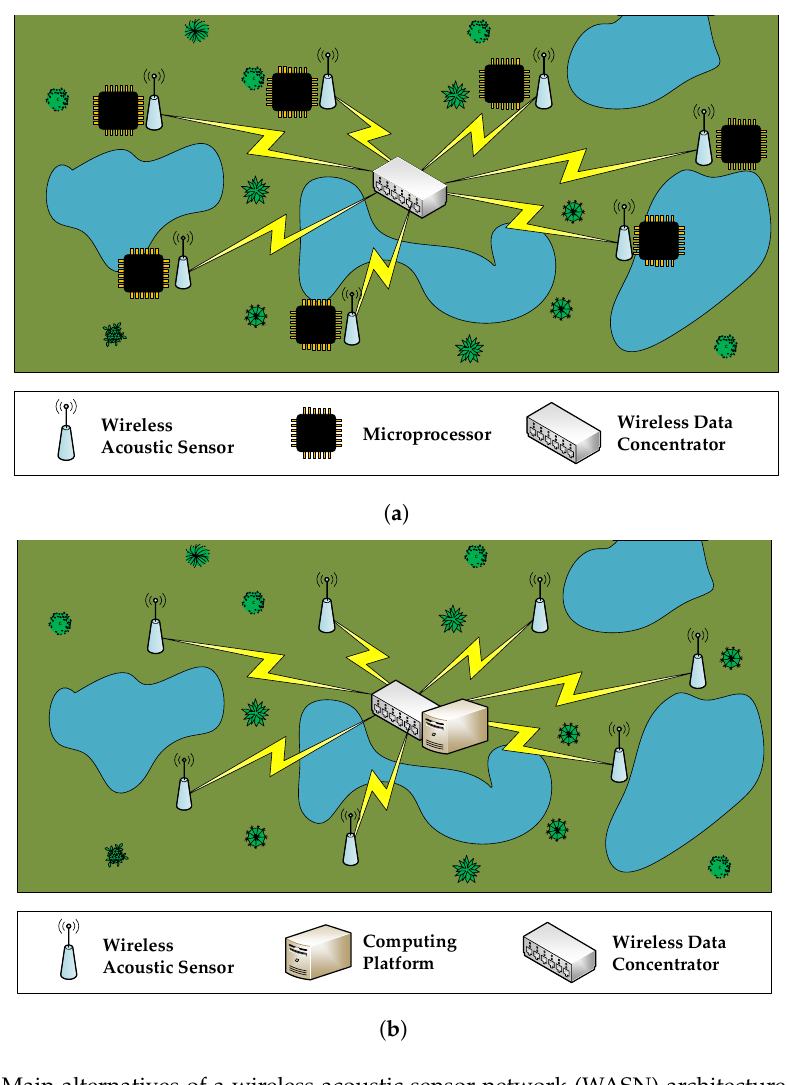
Figure 1. Main alternatives of a wireless acoustic sensor network (WASN) architecture for remote monitoring. ( a ) distributed intelligence; ( b ) centralized